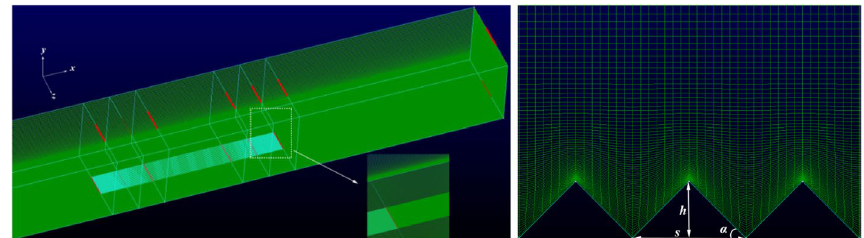
Fig. 4 Schematic of three-dimensional grid (left) and grid distribution near the triangular riblets